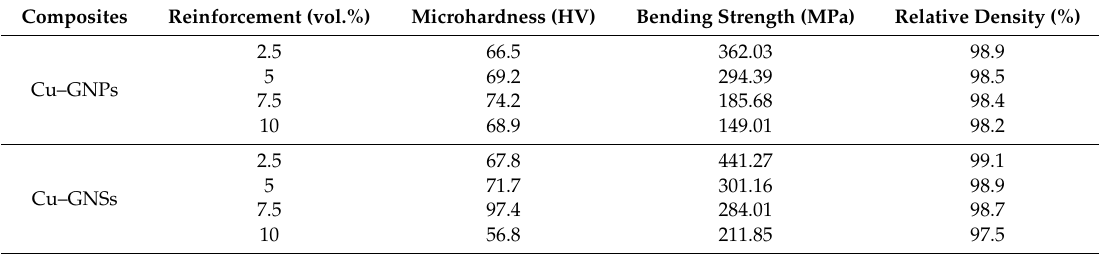
nanocomposites [189].